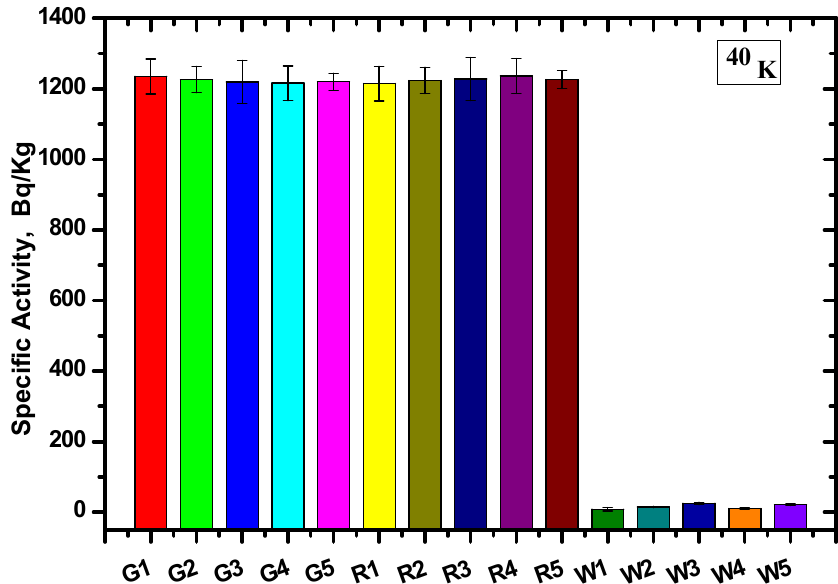
Figure 7. The specific activity for 40 K at 1406 keV for the different granite samples.